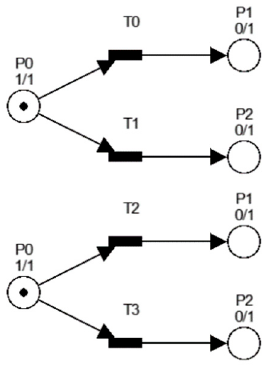
Figure 5. Petri Net model with concurrent parts.